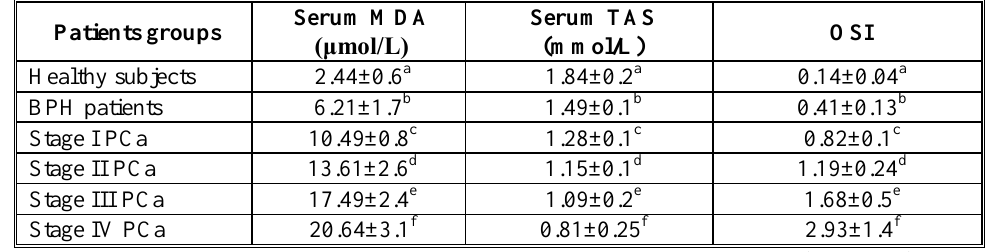
Table 2: Serum levels of MDA, total antioxidant status (TAS) and the oxidative stress index (OSI) in healthy subjects, BPH patients and patients with different stages of malignant prostate cancer.